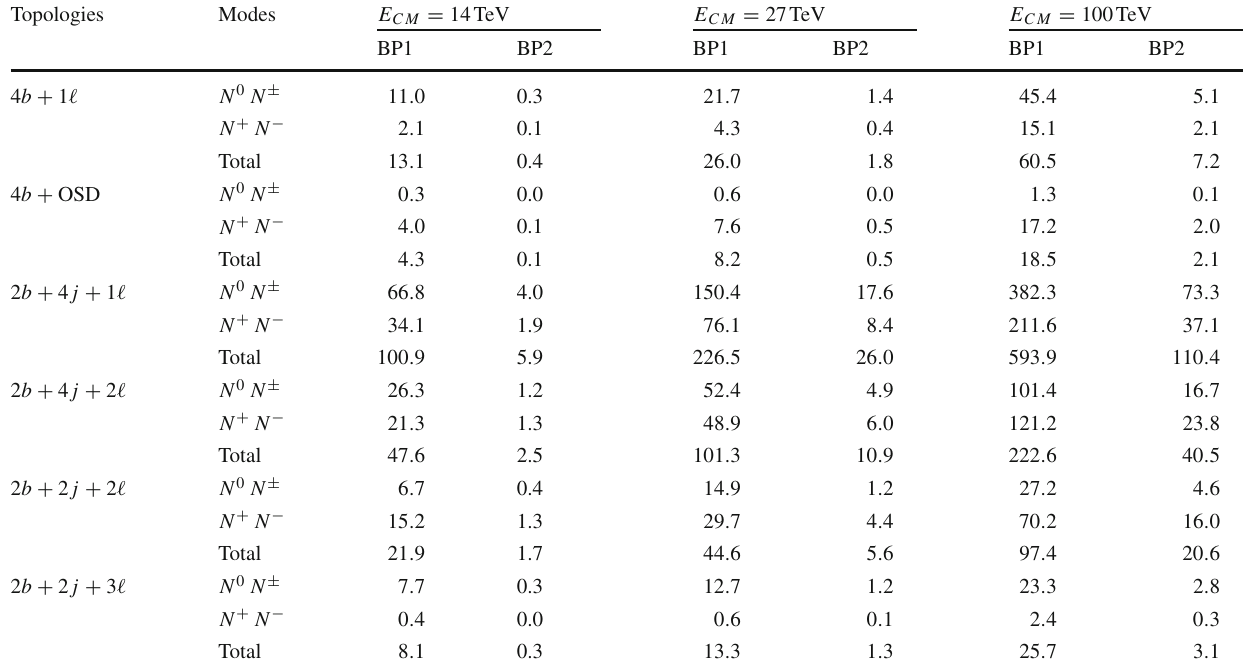
Table 6 Number of events for finalstate topologies containing at least two b -jets for the benchmark points with the centre of mass energies of 14 TeV, 27 TeV and 100 TeV at the LHC with integrated